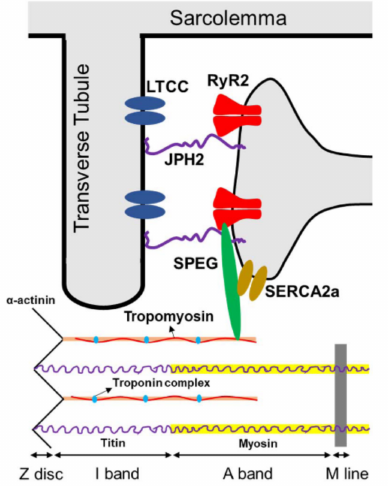
Figure 2. Known targets of SPEG phosphorylation in cardiac muscles, including JPH2, RyR2, SERCA2a, and α -tropomyosin. Abbreviations: SPEG = striated preferentially expressed protein kinase; JPH2 = junctophilin 2; LTCC = L-type calcium channel; RyR2 = ryanodine receptor 2; SERCA2a = sarco-endoplasmic reticulum